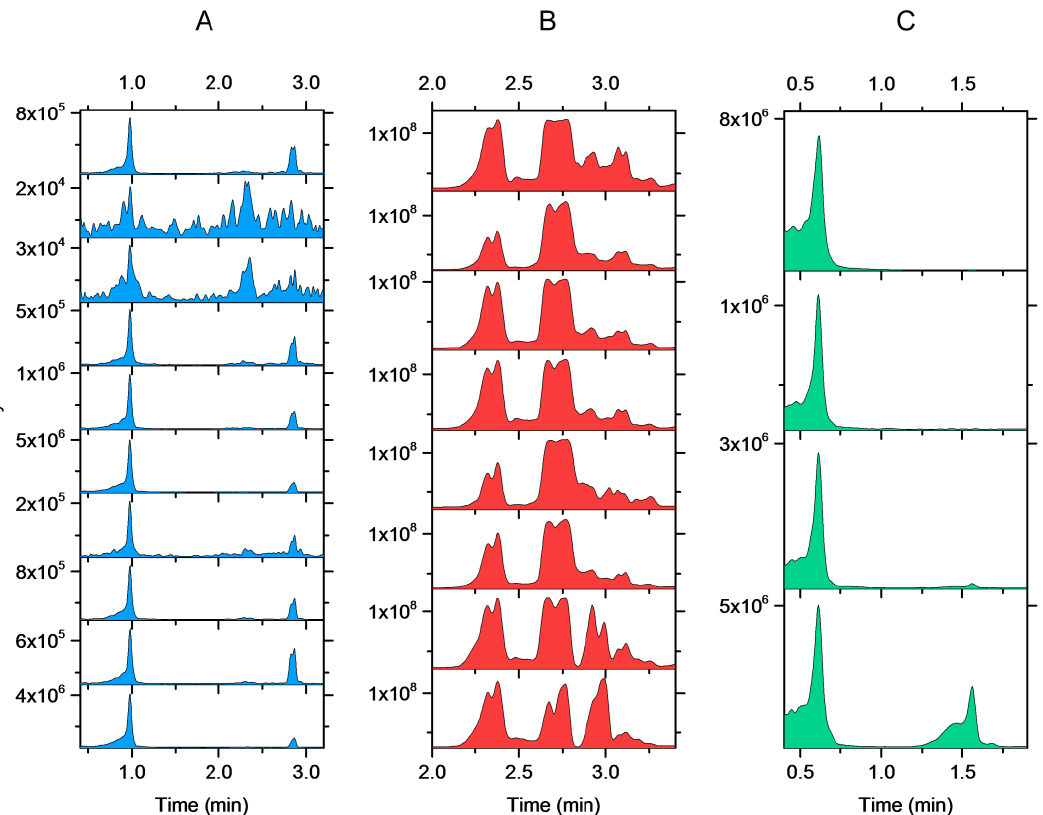
Figure 4. Within-species repeatability of the fingerprints in the different plant individuals of ( A ) Sorbus hybrida , ( B ) Alnus glutinosa, and ( C ) Salix phylicifolia recorded with the species-specific method I. The results were obtained for the same samples as in Figure 3.